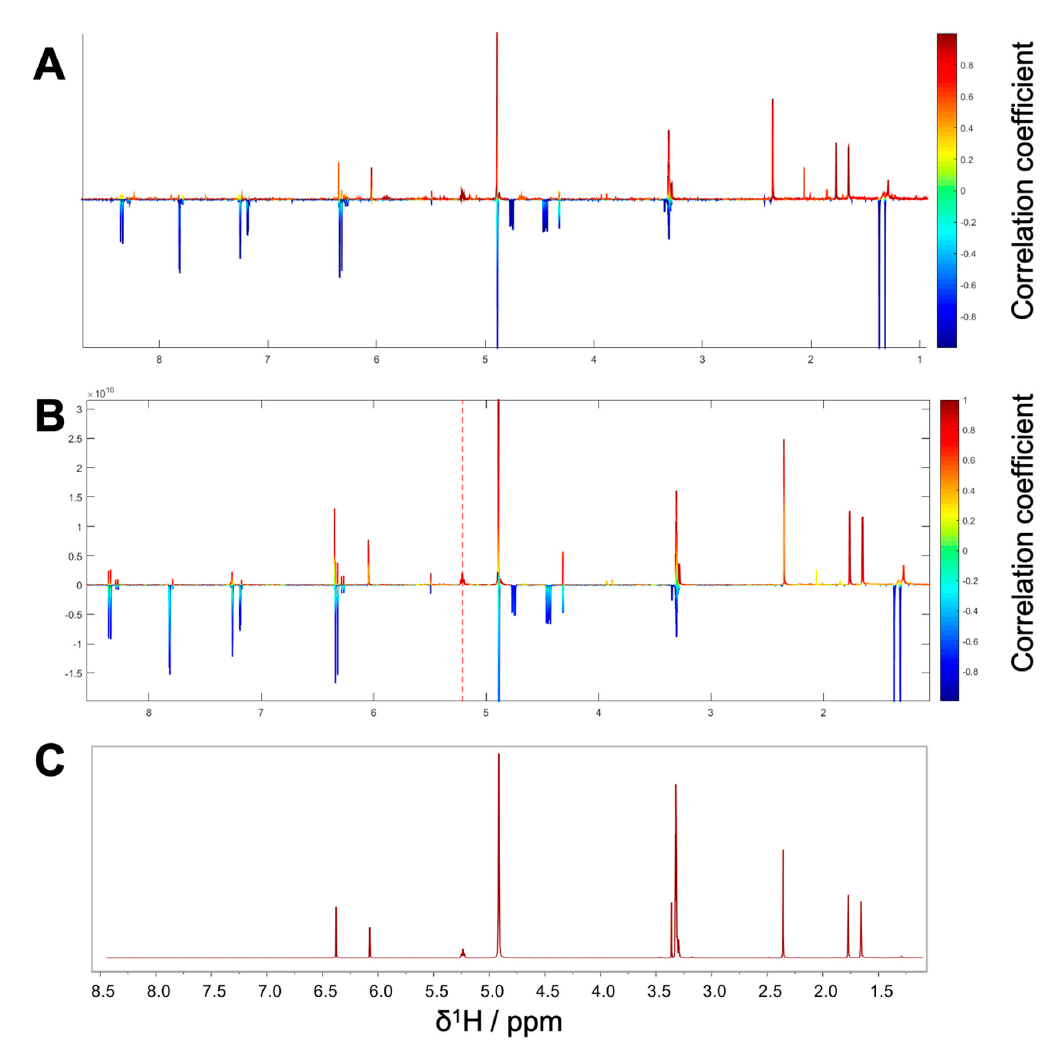
Figure 4. Package II ( A ) 1 H NMR pseudo-spectrum showing the HetCA of 1 H NMR spectra and NF-kB reporter-gene inhibition data of the microfractions PO01_15–PO01_17. ( B ) STOCSY plot of package II. The signal at δ H 5.21 was chosen to obtain the information in which molecule(s) share this hot feature. ( C ) 1 H NMR spectra of the isolated active compound 2 .